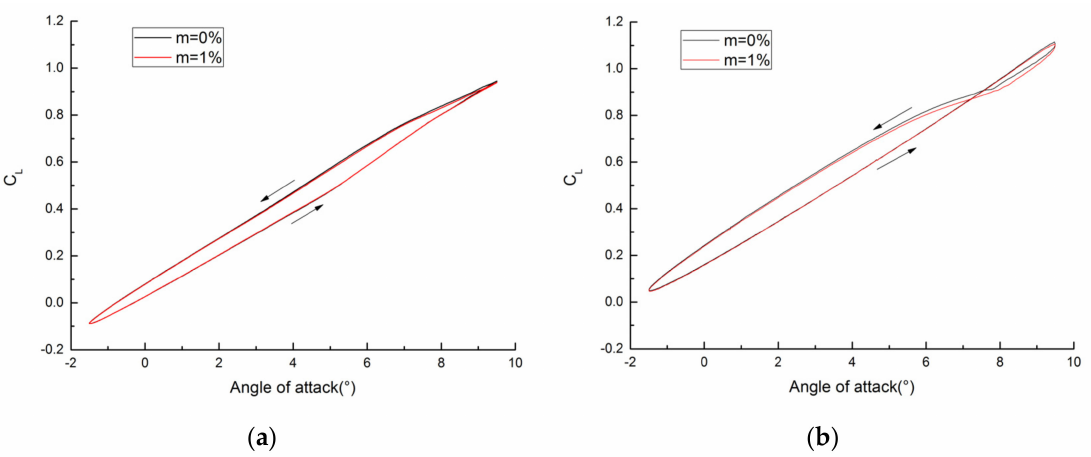
Figure 12. Hysteresis loops of two airfoils for Case 4: ( a ) NACA0012 airfoil; ( b ) S809 airfoil.